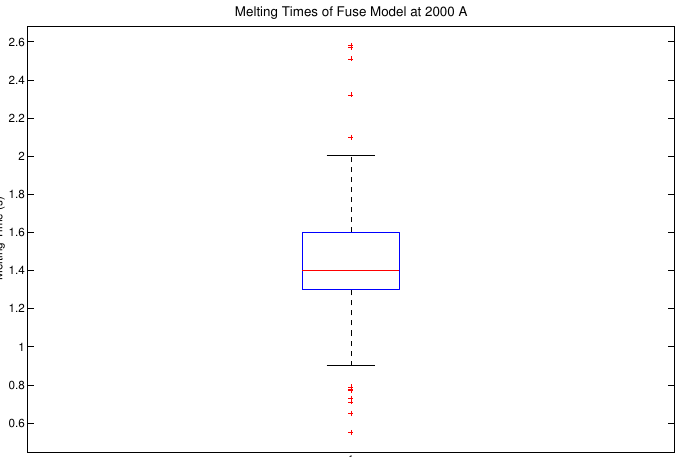
Figure 8. Histogram of a random sample of fault clearing time distribution of 100 trials.